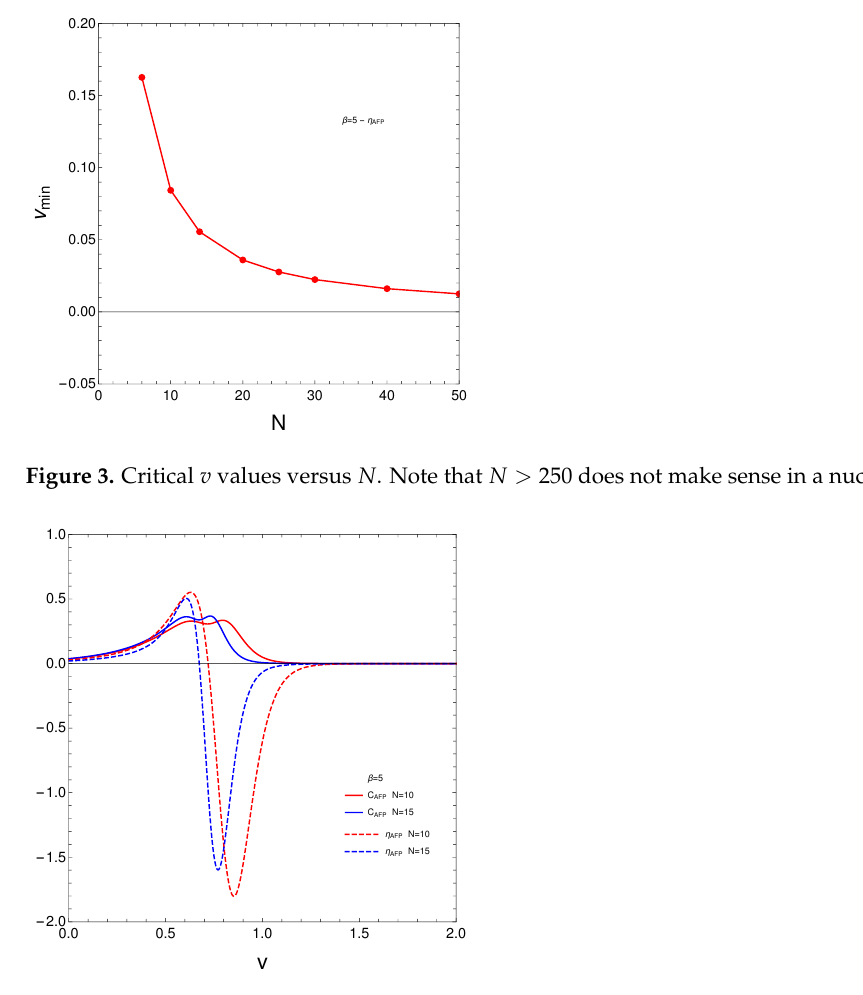
Figure 4. Complexity C (continuous line) and η AFP (dashed) plotted versus v . The effective coupling constant is v / N . Two N values are used.